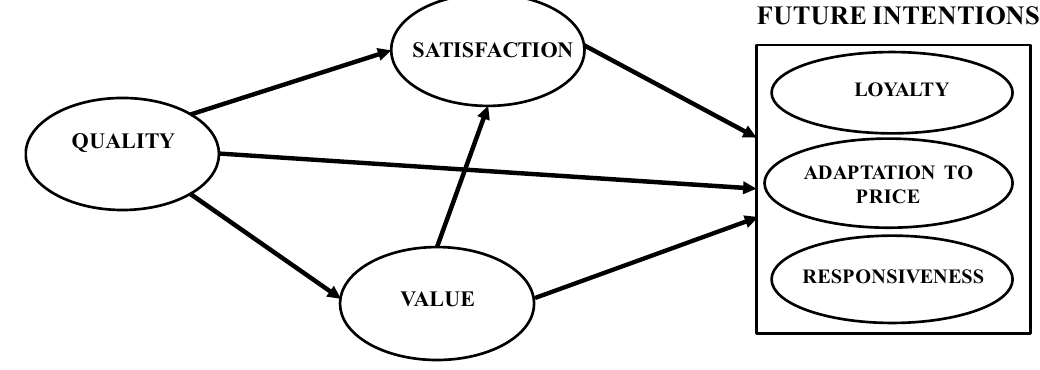
Figure 1. Model of the relationship between quality, value, satisfaction, and future intentions.